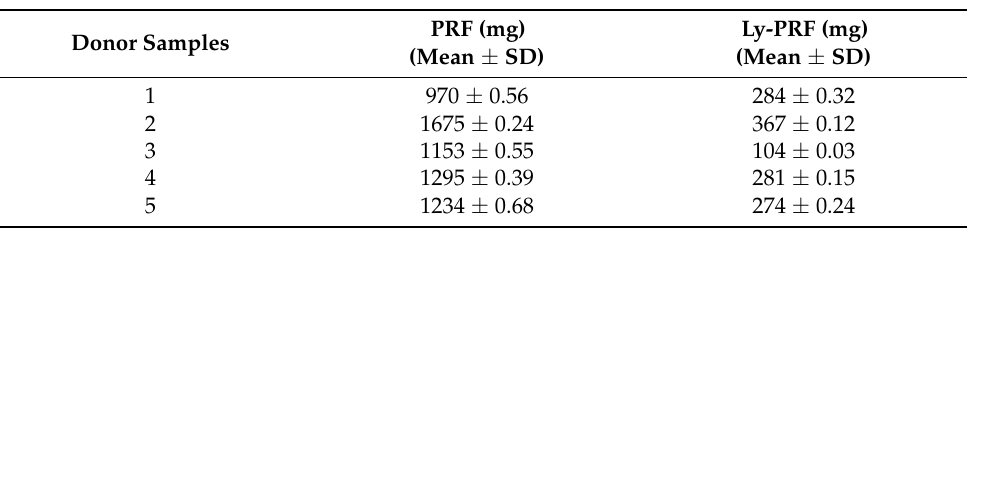
Table 1. Comparative weight of PRF and